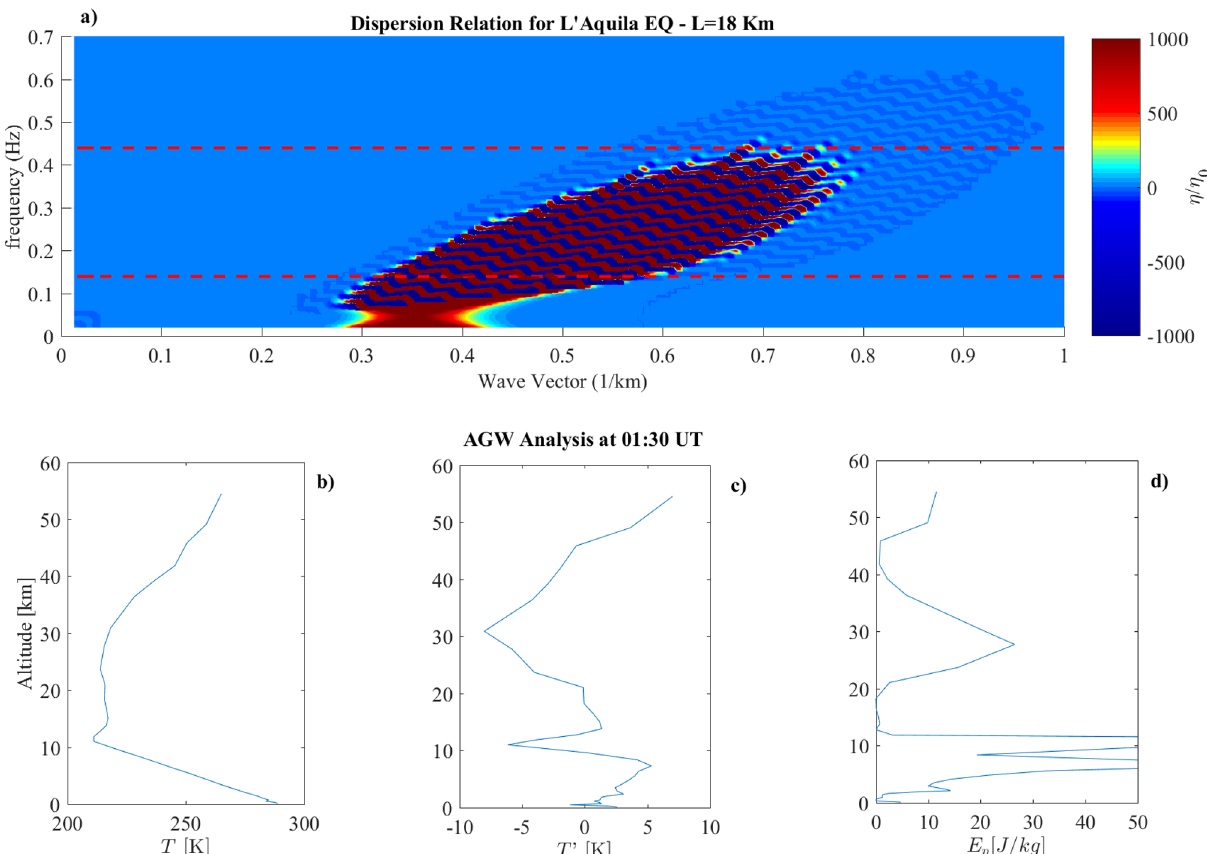
Figure 4. ( a ) Dispersion relation evaluated for the L’Aquila Earthquake using the parameters in Table 1. The dashed line represents the parameter c 0 / 2 h . ( b ) Vertical Temperature profile over the EQ epicenter. ( c ) Fluctuations of the vertical temperature profile over the EQ epicenter. ( d ) Potential energy density vertical profile over the